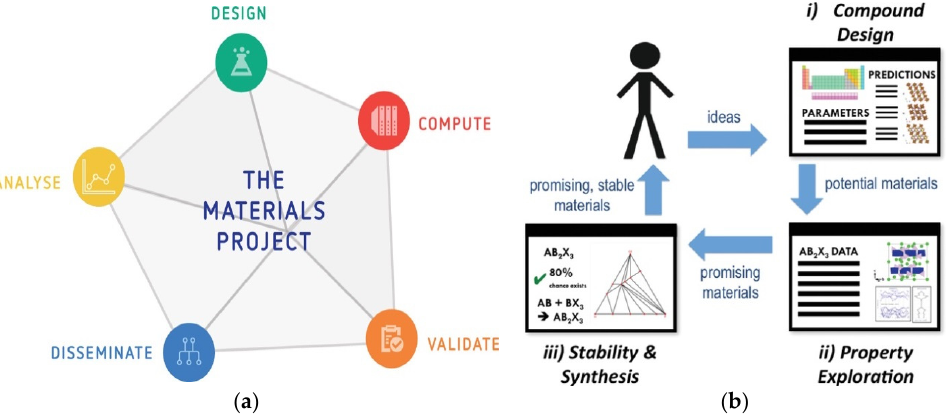
Figure 17. ( a ) Materials project thrusts. ( b ) In silico prototyping and iterative design steps of materials [292].